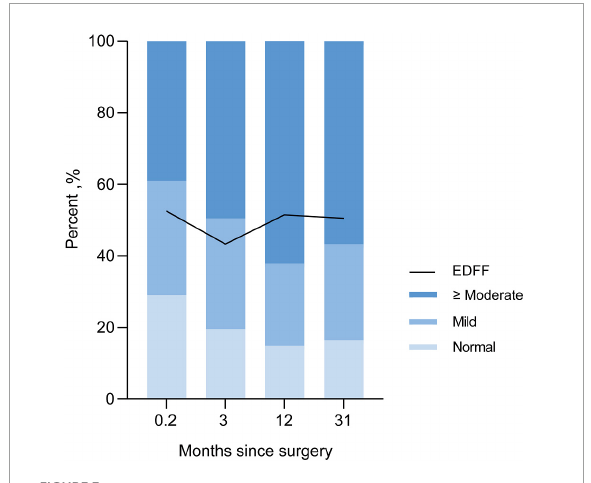
FIGURE3 Incidence of EDFF and rate of different severity of pulmonary regurgitation in postoperative and follow-up echocardiography. EDFF, end-diastolic forward flow.